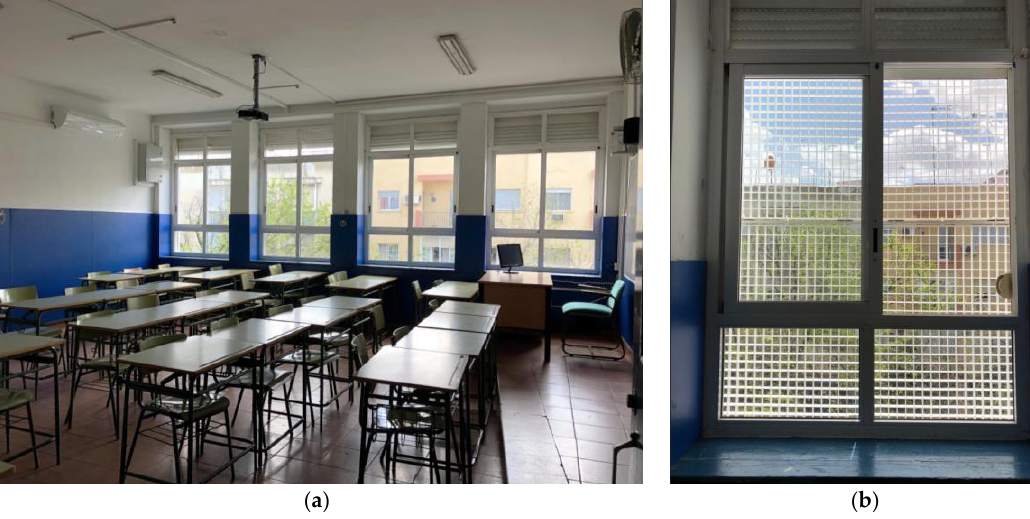
( c ) Figure 3. ( a ) Indoor view of the classroom with no egg-crate devices (room B); ( b ) indoor view of the solar protection designed (room A); and ( c ) egg-crate device designed for each window. A direct expansion heat pump was installed for the air conditioning systems in both classrooms, connected to two wall indoor units and an exterior inverter unit. These systems had a cold/heat capacity of 6.8/7.8 kW, with an energy efficiency of SEER (Seasonal Energy Efficiency Ratio) 6.1 (A++) and SCOP (Seasonal Coefficient Of Performance) 3.8 (A). Finally, it should be noted that both classrooms still preserved the original lighting system consisting of four luminaires, each with two 2 × 36 W fluorescent lamps.